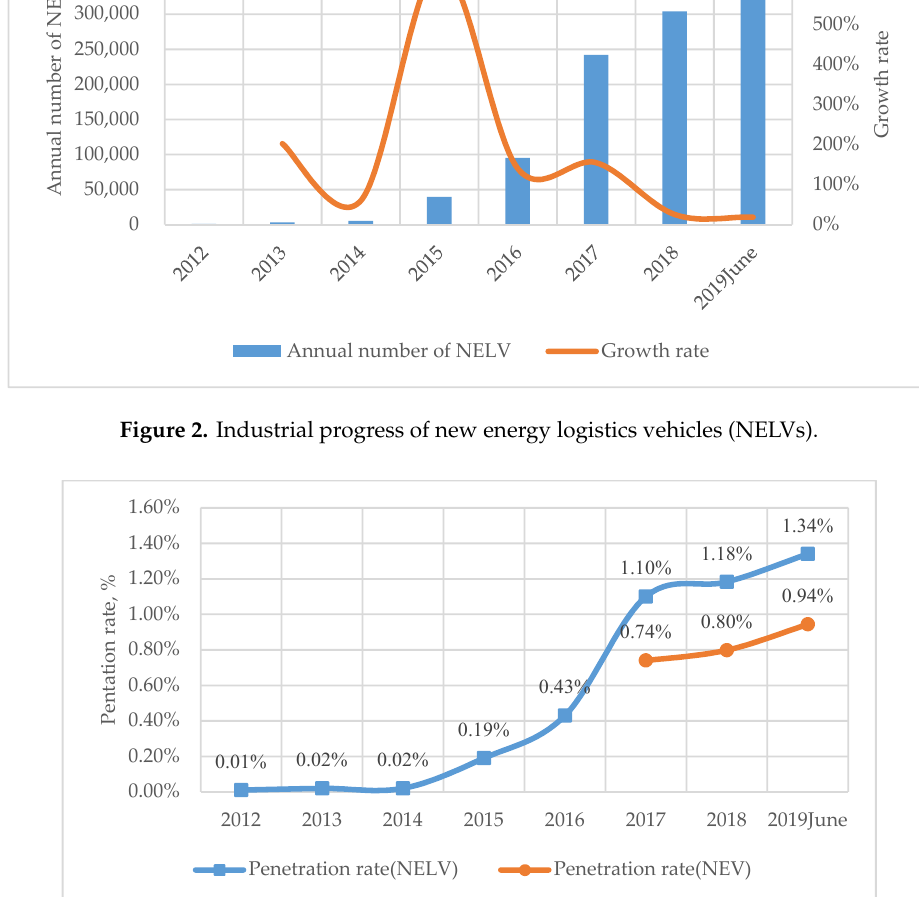
Figure 3. Penetration rates of NELVs and NEVs.